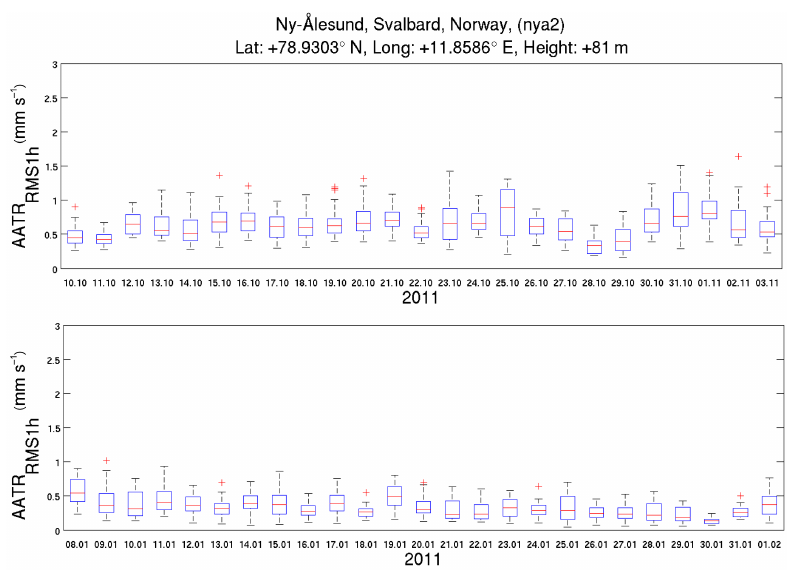
Figure 1. AATR box plot for the nya2 station. Values for the disturbed period are presented in the top panel, while calm period values are in the bottom